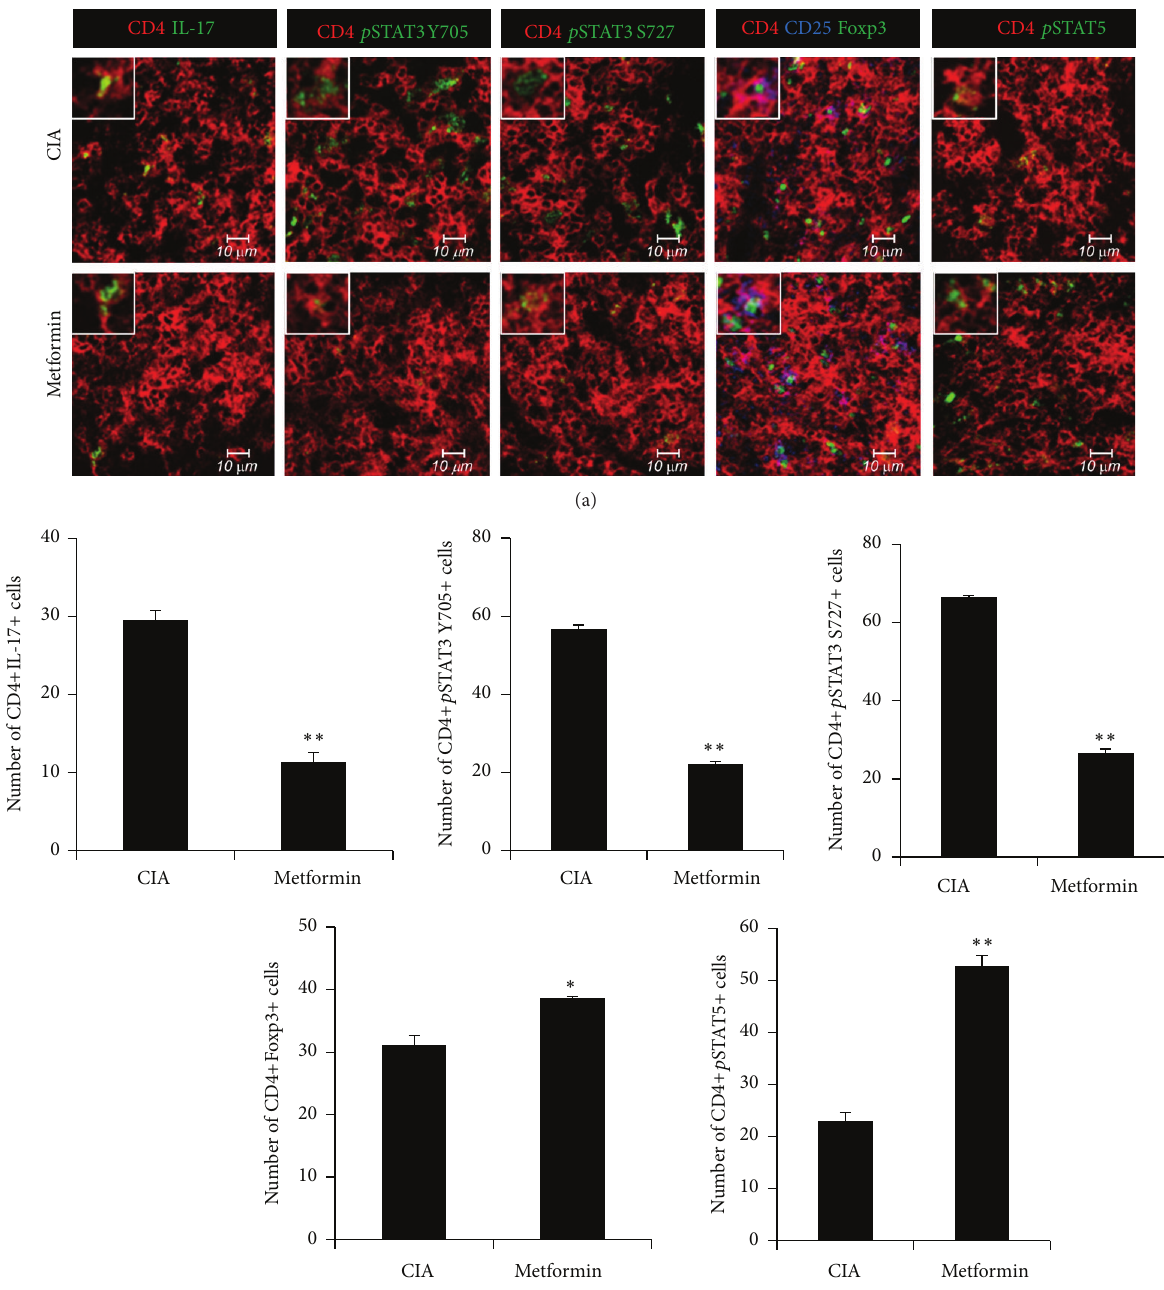
Figure 2: Regulation of Th17 cells and Foxp3+ regulatory T cells in CIA spleen. Spleen tissue was obtained from metformin-treated CIA and control CIA on day 35 after first immunization. (a) Confocal staining examined by antibodies: Th17 cell was stained with CD4 (red) and IL-17 (green). CD4+ CD25+ Foxp3+ regulatory T cells were stained with CD4 (red), CD25 (blue), and Foxp3 (green). For activated STATs analysis, the tissues were stained with CD4 and p STAT3 S727, p STAT3 Y705, or p STAT5. All images were performed for each mouse ( 𝑛 = 5 ), showing representative images (scale bar = 10 𝜇 m). (b) The mean values are presented in the form of a histogram by four individuals. Results are shown as mean ± SD ( 𝑛 = 5 mice per group). Mean ± SD of three independent experiments ( ∗ 𝑃 < 0.05 ; ∗∗ 𝑃 < 0.01